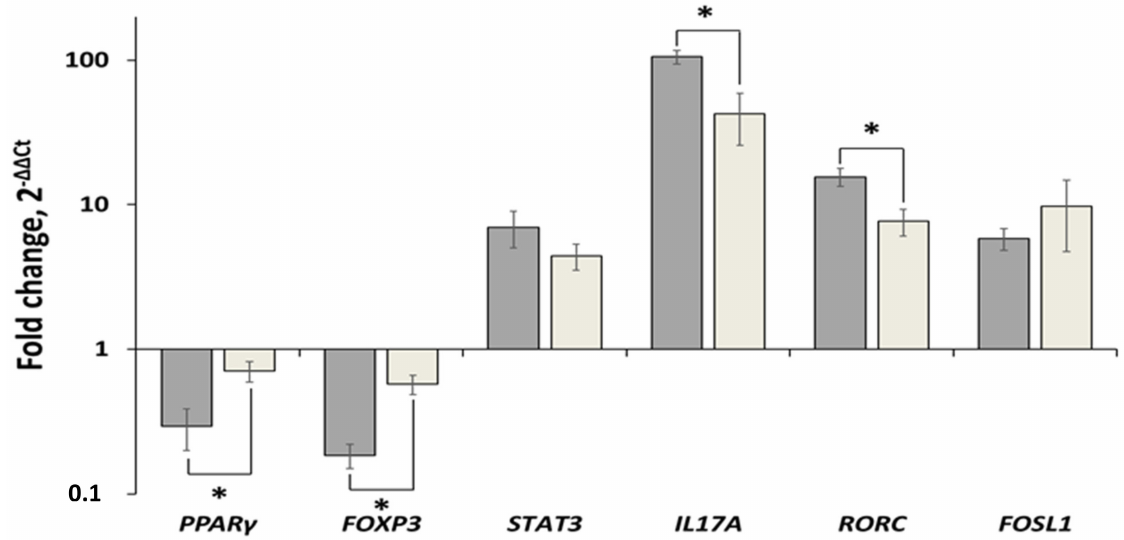
Figure 2. Comparative analysis of changes in the expression levels of PPAR γ , STAT3 , IL17A , RORC , FOXP3 and FOSL1 in lesional skin and CD3 + T cells of psoriasis patients. Dark grey bars—lesional vs. uninvolved skin; Light grey bars—CD3 + cells of psoriasis patients vs. same cells of healthy volunteers. The level of gene expression in control group was set to 1. Statistically significant changes in gene expression ( p < 0.05) are marked with asterisk sign